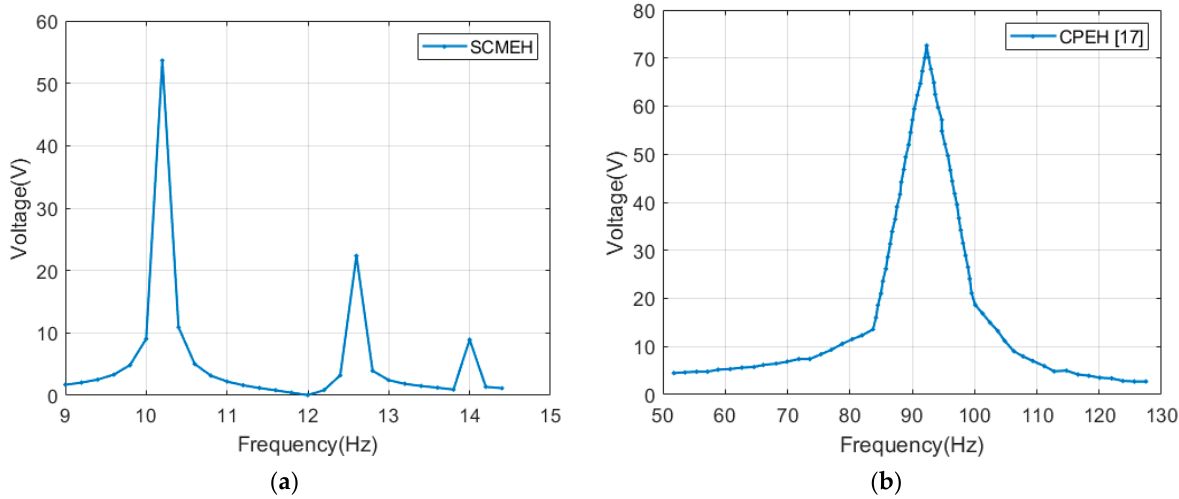
Figure 8. Comparison of performance between SCMEH and CPEH: ( a ) SCMEH and ( b ) CPEH [17].